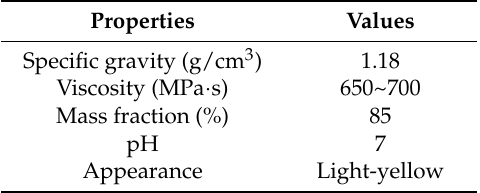
Table 2. Properties of water-based polyurethane (PU).